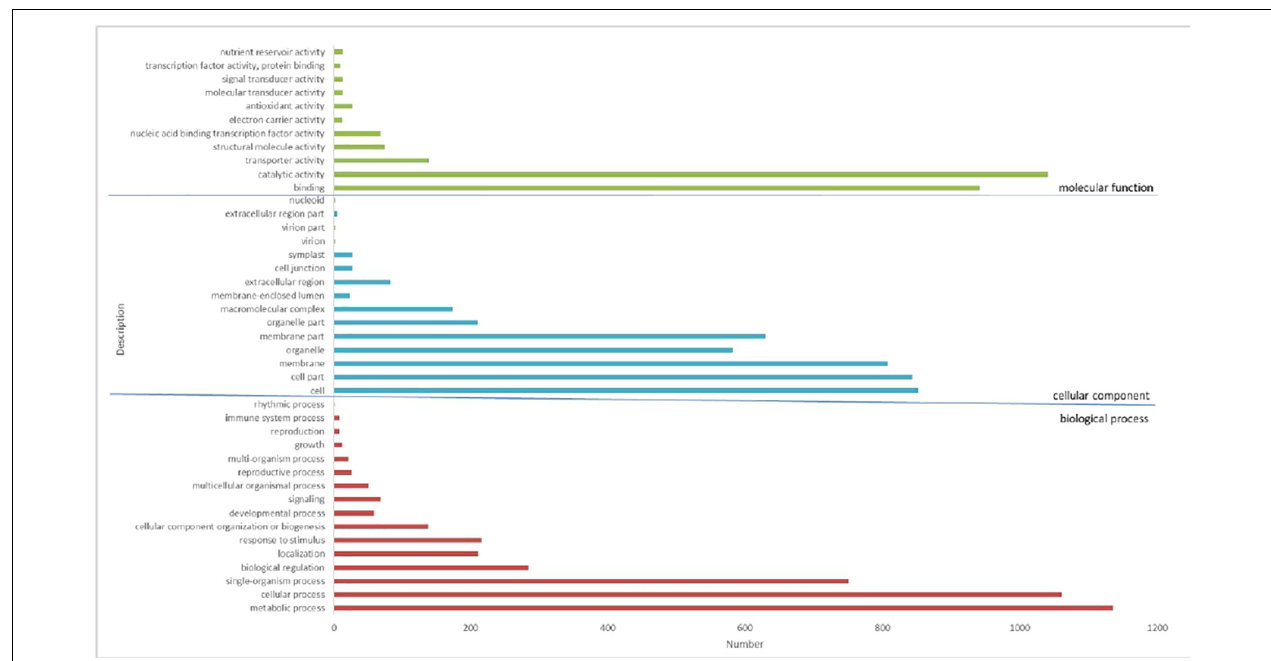
FIGURE 6 | Gene ontology (GO) classification of DEGs by analysis. A total of 2,065 DEGs have been assigned GO terms and they are classified into three GO categories: biological process, cellular component, and molecular function.